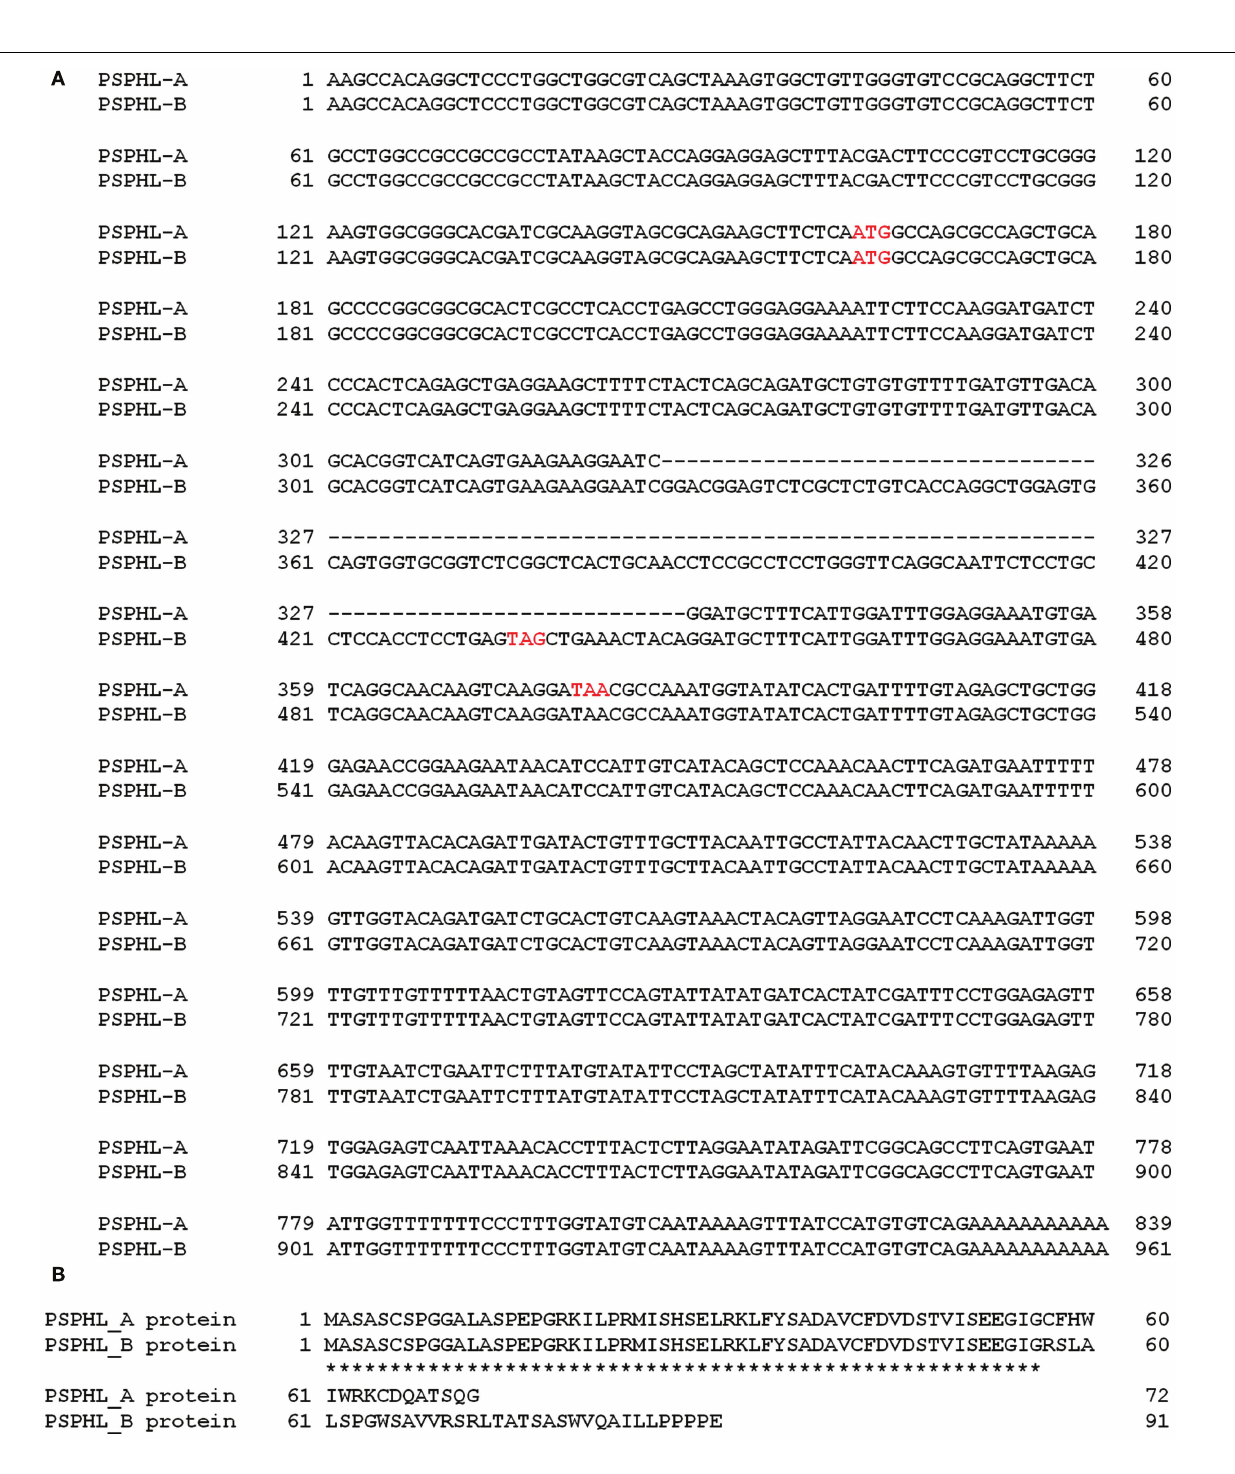
FIGURE 5 | (A) mRNA homology of splicing variants of PSPHL PSPHL_A mRNA sequence (839bp) is 100% match to the PSPH homolog C09 gene (503bp) and L-3-phosphoserine-phosphatase homolog (839bp; AJ001612).